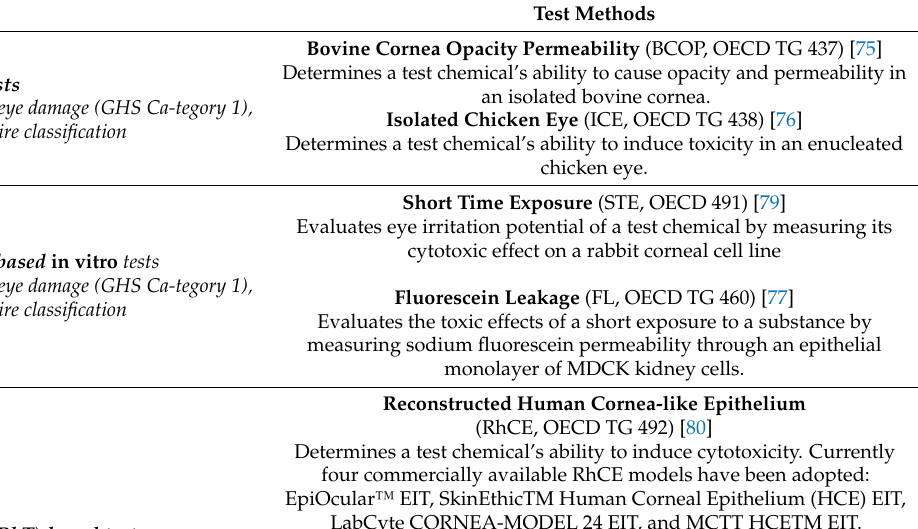
Table 5. Grouping of NAMs validated to assess serious eye damage/irritation